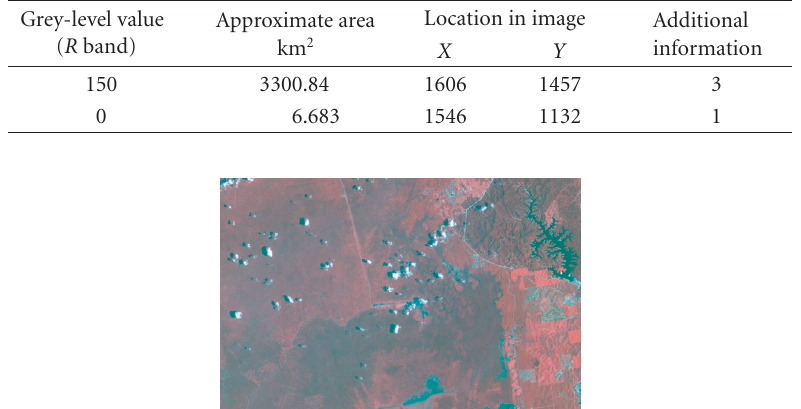
Table 4.1. Feature descriptors from Figure 4.3. Location is in pixel coordinates.